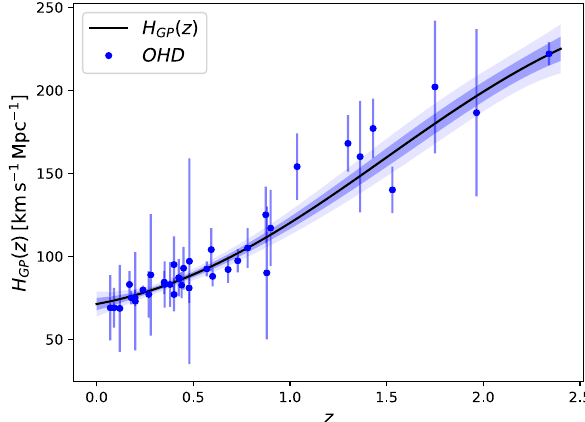
Fig. 1 Reconstruction of H GP ( z ) via GP from OHD (Table 1). The blue points with errors are OHD. The black line is the GP reconstruc- tion result H GP ( z ) . The blue bands show the 1 σ and 2 σ regions of reconstruction